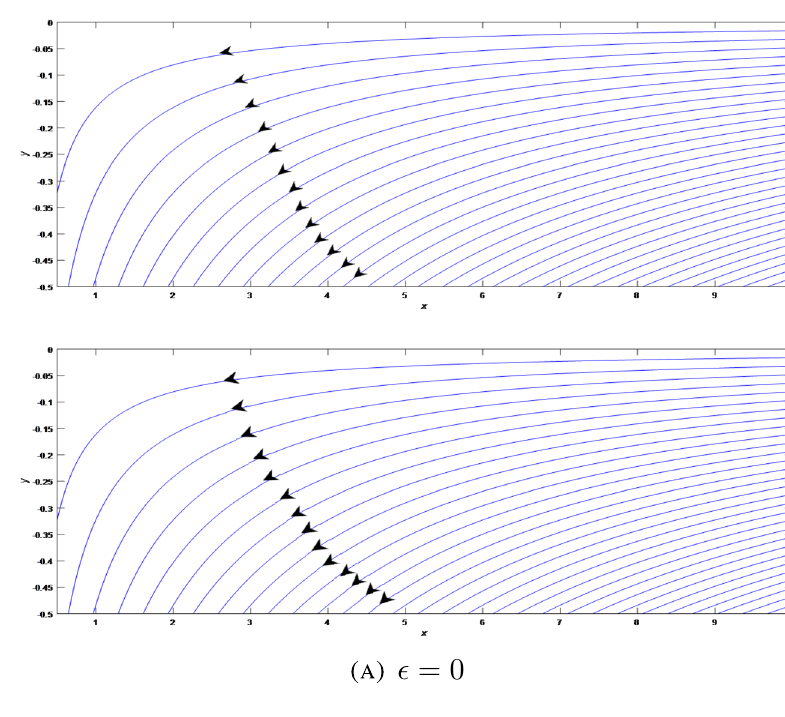
Figure 8. Streamlines of the film flow for varying time steps t axisymmetric constant wall ( (cid:31)